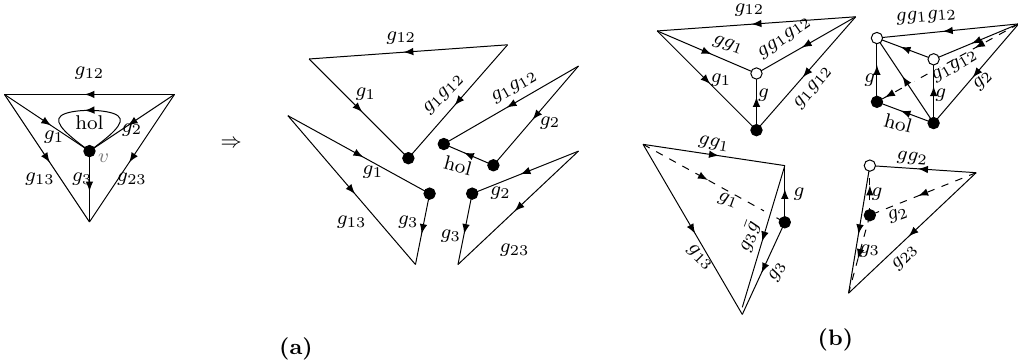
Figure 12 . (a) We separate the triangles. Each solid dot denotes the vertex v . (b) Assigning 3-cocycles to the 5